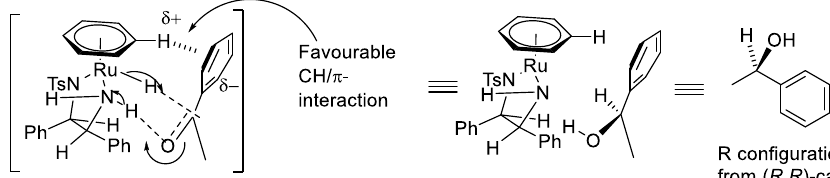
Figure 3. Interaction of substrate with η 6 -arene ring.